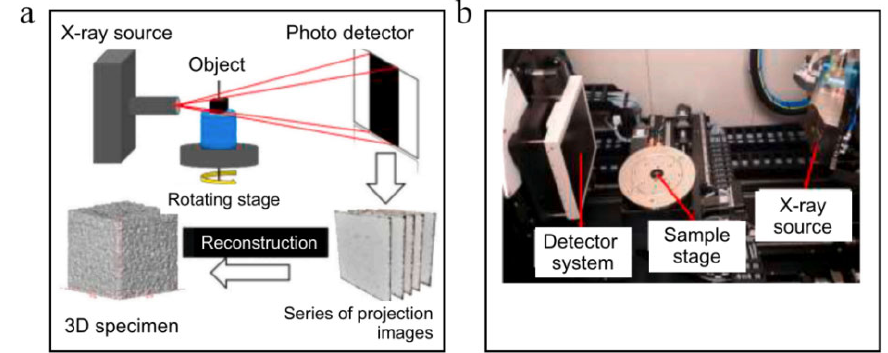
Fig. 37 (a) Schematic of industrial X-ray tomography; (b) main components of 3D CT X-ray computed tomography. Reproduced with permission from Ref. [104], © Elsevier B.V. 2020.